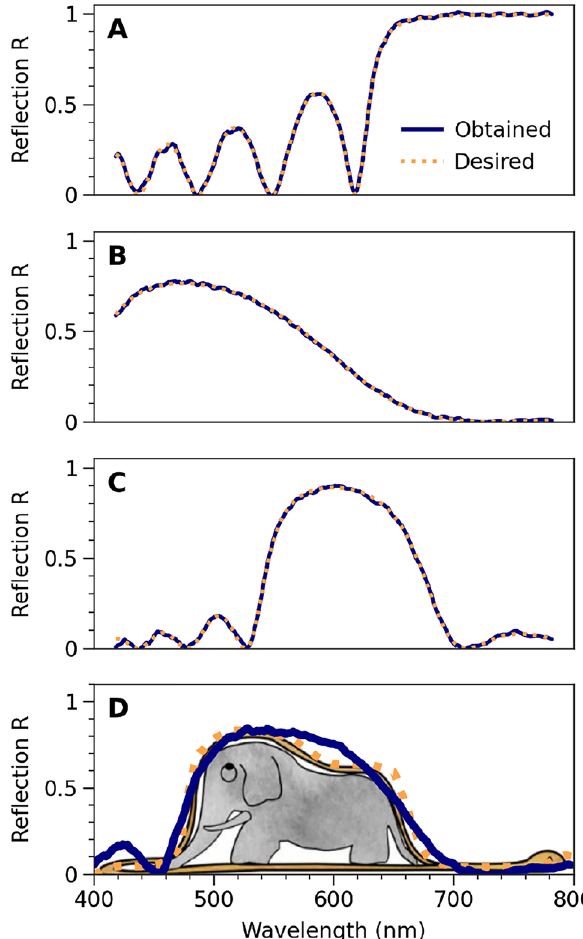
Figure 4: Inverse design of a general Bragg reflector. (A – C) examples of desired reflection spectra from the test set in combination with the spectra obtained through inverse design. The desired spectrum is shown in orange and the spectrum corresponding to the obtained resonator parameters is shown in blue. (D) Fitting an elephant. The spectrum, shown in orange, approximates the shape of the elephant. The spectrum that corresponds with the obtained resonator parameters is shown in